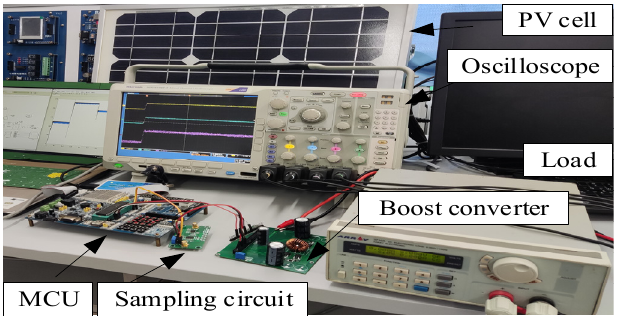
Figure 19. Experimental platform.